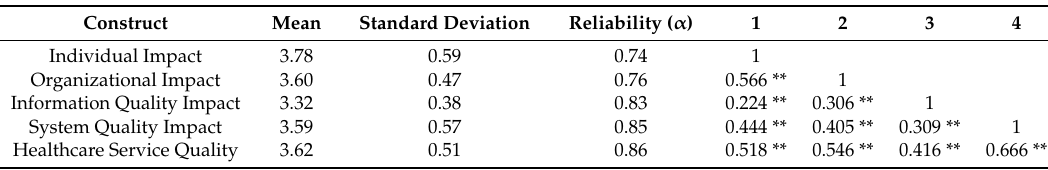
Table 2. Descriptive, reliability coefficients & correlation